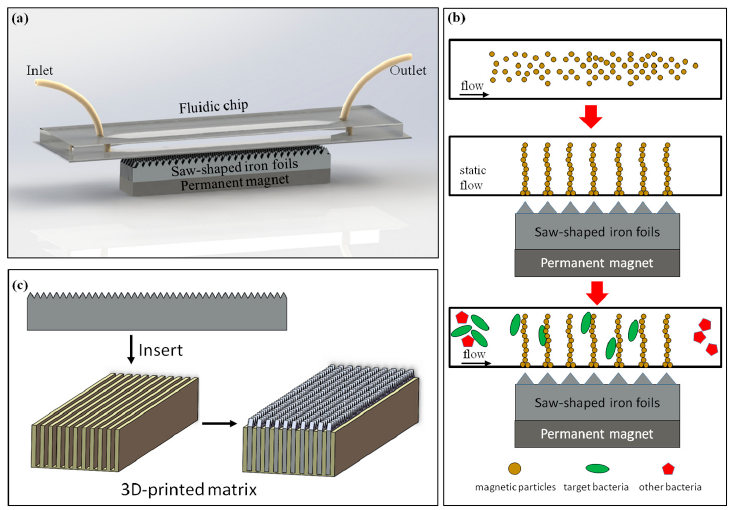
Figure 1. ( a ) Schematic view of the fluidic device for immunomagnetic separation; ( b )